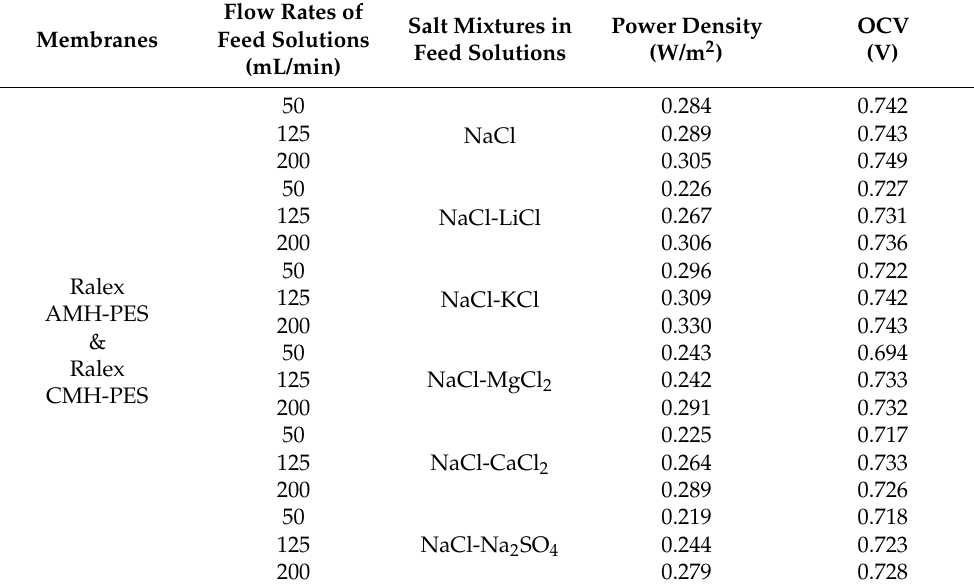
Table 6. Power density and OCV results of the studies performed by Ralex AMH-PES and Ralex CMH-PES